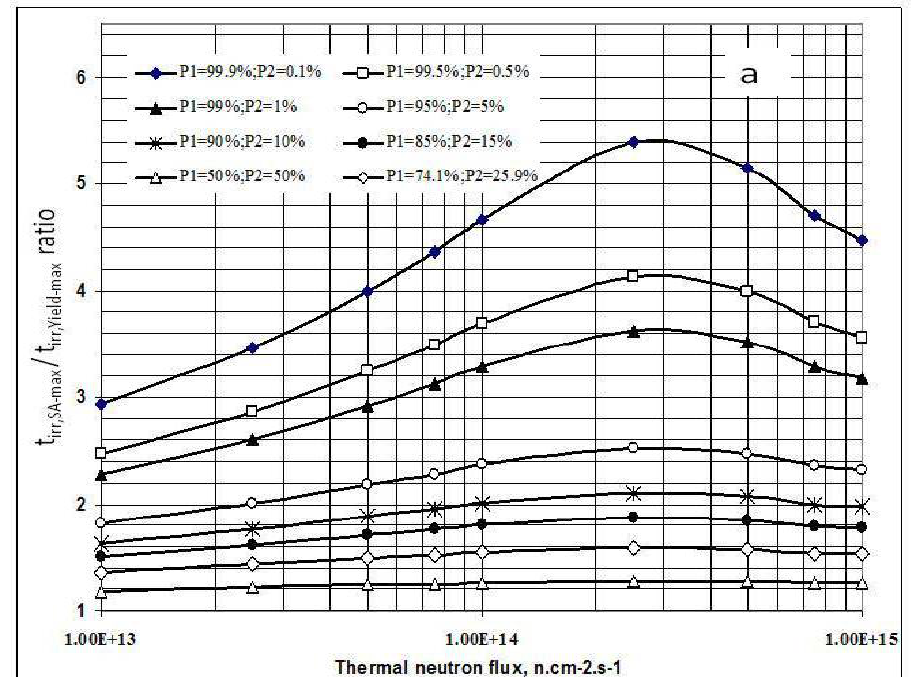
Figure 3. a - Irradiation time ratio (t composition. b - Maximum specific radioactivity of 177 Lu vs . thermal neutron flux and target